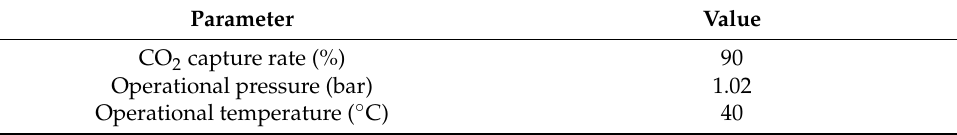
Table 6. Design specifications of the